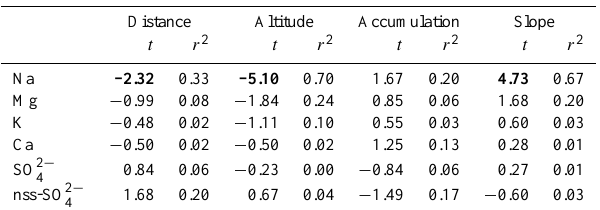
Table 3. Regression model explaining the relationships between mean element concentrations in surface snow (AD2006–2008) and some physical characteristics of the Progress–Vostok traverse. Data reported are t values ( t ) and determination coefficients ( r 2 ) . Signif- icant t values ( p < 0.05, n = 13) are marked in